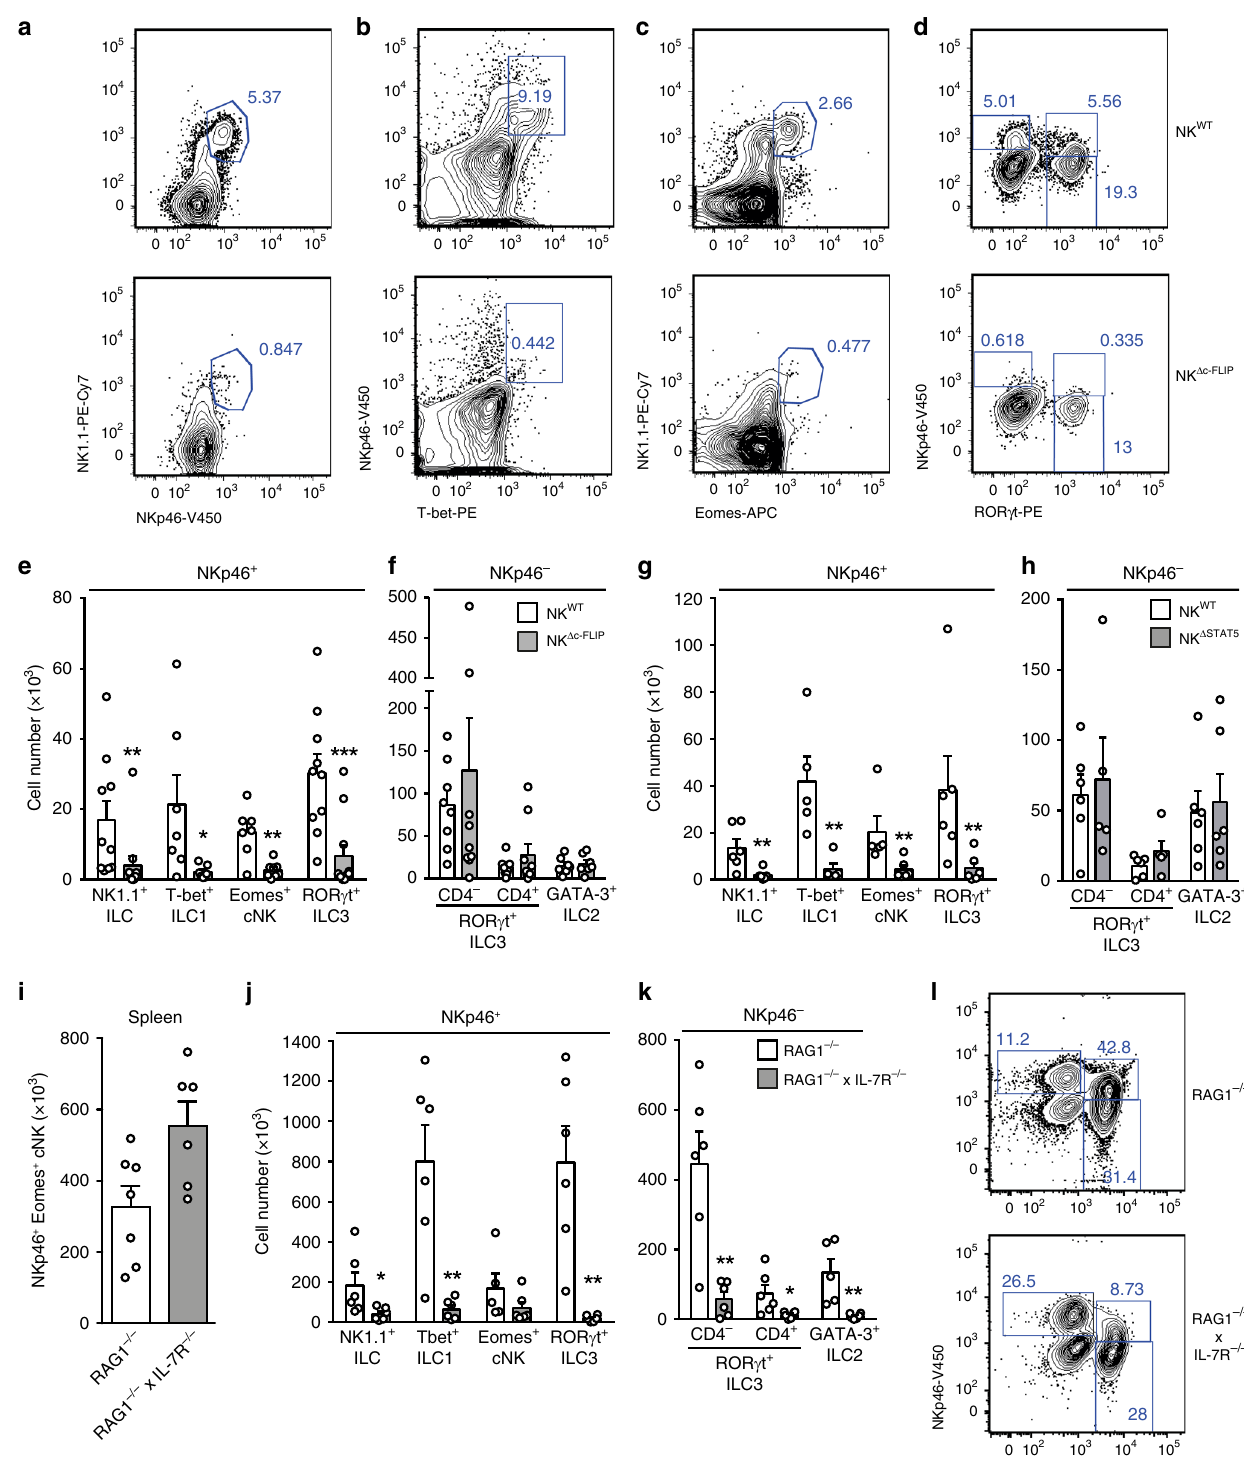
Fig. 3 NK Δ c-FLIP mice lack IL-7- and IL-15-dependent NKp46 + ILC in the small intestine. a – h and j – l Leukocytes were isolated from the small intestinal (SI) lamina propria of a – f NK Δ c-FLIP , g , h NK Δ STAT5 , j – l RAG1 − / − × IL-7R − / − and respective control mice. i Spleen cells from RAG1 − / − × IL-7R − / − and RAG1 − / − mice were analyzed. a – h and j – l To discriminate between different subsets of NKp46 + (ILC: NK1.1 + ; ILC1: T-bet + , cNK: Eomes + ; ILC3: ROR γ t + ) and NKp46 − ILC (ILC3: ROR γ t + ; ILC2: GATA3 + ), cells were analyzed by fl ow cytometry after gating on Lin − CD45 + cells. e – k Absolute cell numbers are shown as mean + SEM. a – d and l Shown are representative contour plots and e – k pooled results from 3 to 5 independent experiments with a total of e , f 10 – 11, g , h 6, i 6 – 7 and j , k 6 mice per group. e For NKp46 + ILC, ILC1, cNK, and ILC3, 10-11, 7, 7 – 8, and 10 – 11 samples were analyzed, respectively. f For NKp46 − CD4 − ILC3, CD4 + ILC3 and ILC2, 8 – 9, 8 – 9 and 7 samples were analyzed, respectively. g , h 5 – 6, i 6 – 7, j , k 5 – 6 samples were analyzed for the indicated ILC subsets. a – d and l Numbers indicate percentages. e – k Source data are provided as source data fi le; * p ≤ 0.05; ** p ≤ 0.005; *** p ≤ 0.001; **** p ≤ 0.0001 (two-tailed Mann – Whitney U